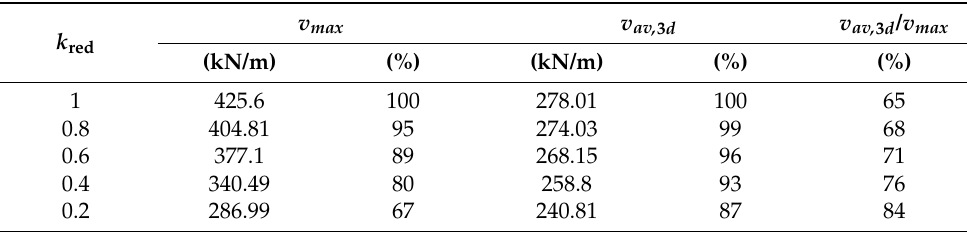
Figure 6. Influence of slab shear stiffness reduction to shear forces around the control perimeter at 0.5 d from the shear cap face. Table 1. Influence of slab out-of-plane shear stiffness reduction k red to shear forces around the control perimeter at 0.5 d from the shear cap